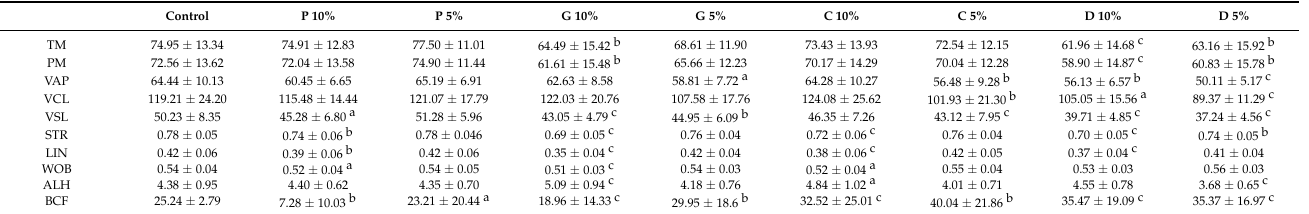
Table 1. CASA parameters of bull semen samples after exposure to various plant-based substances at Time